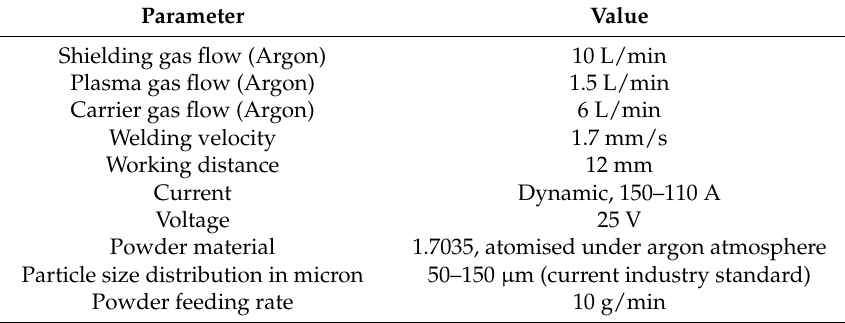
Figure 2. ( a ) Welding equipment, ( b ) plasma-transferred arc process, 41Cr4 on C22.8. Table 2. Process parameters of PTA deposition welding.